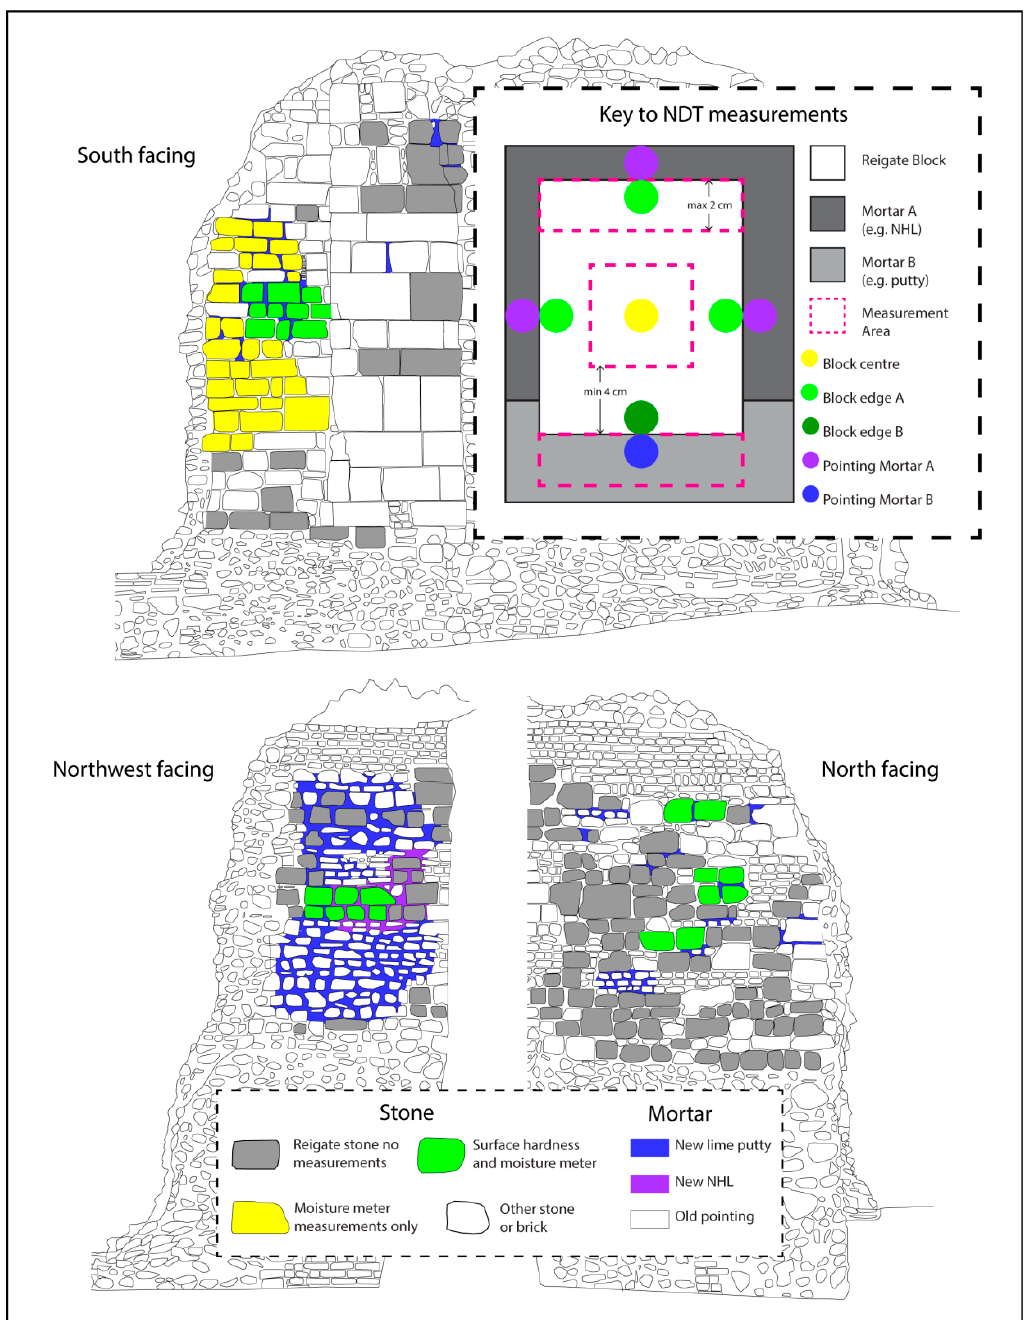
Figure 2. Schematic views of Wardrobe Tower showing distribution of Reigate Stone and areas of non-destructive testing (NDT) measurements in field surveys. Inset shows methodology of NDT measurements (used on dark blue blocks), with dotted squares describing regions in which joint, block edge and block centre measurements were taken. Between 1 and 8 measurements were taken for each circle, depending on survey date and device used.